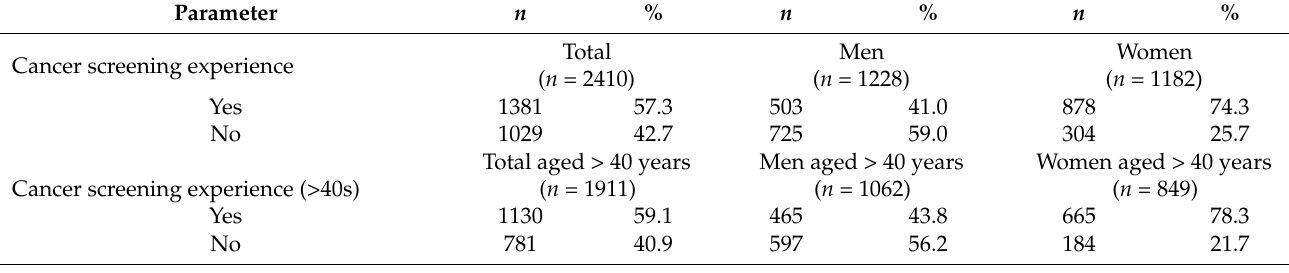
Table 2. Cancer screening